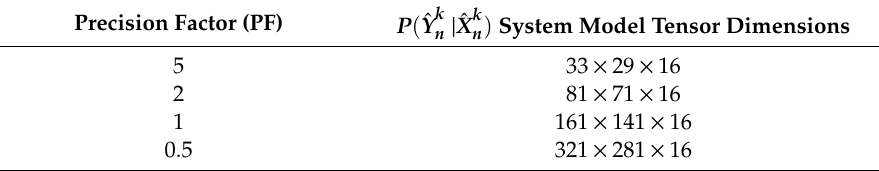
Figure 12. Model accuracy improvement versus a number of the received frames from the simulation results. Data rate = 52 Gb / s, P tx = − 7 dBm, and L = 1600 km. Table 2. P ( ˆ Y k n | ˆ X k n ) system model dimension versus precision factor (PF) extracted by simulation (number of OFDM frames = 1024).